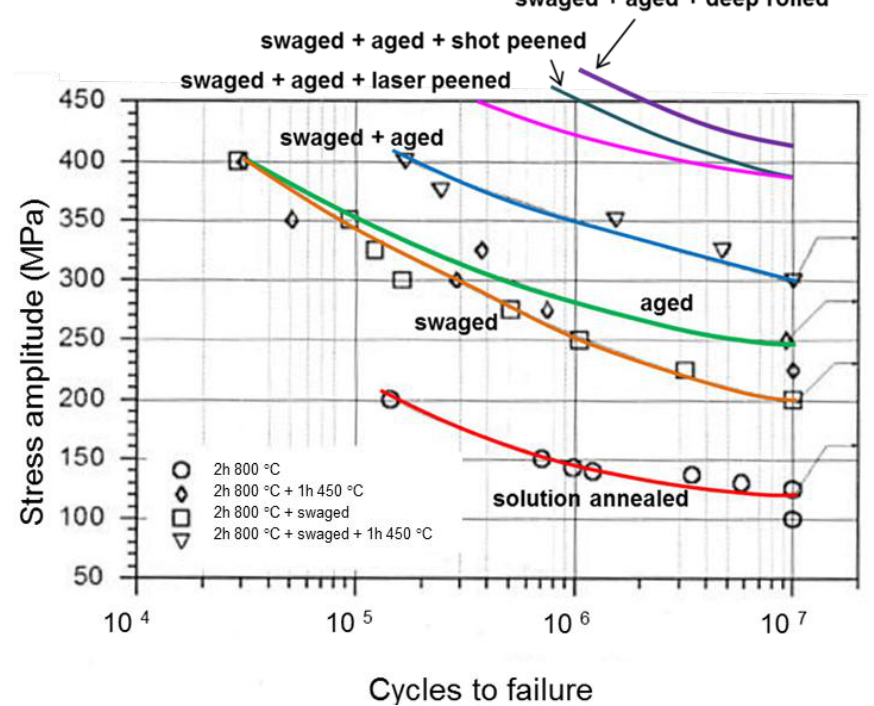
Figure 14. Wöhler-curves (rotation bending, R = −1) of swaged and non-swaged optimized precipitation hardened CuNi3Si1Mg for different mechanical surface treatments (part of this data from